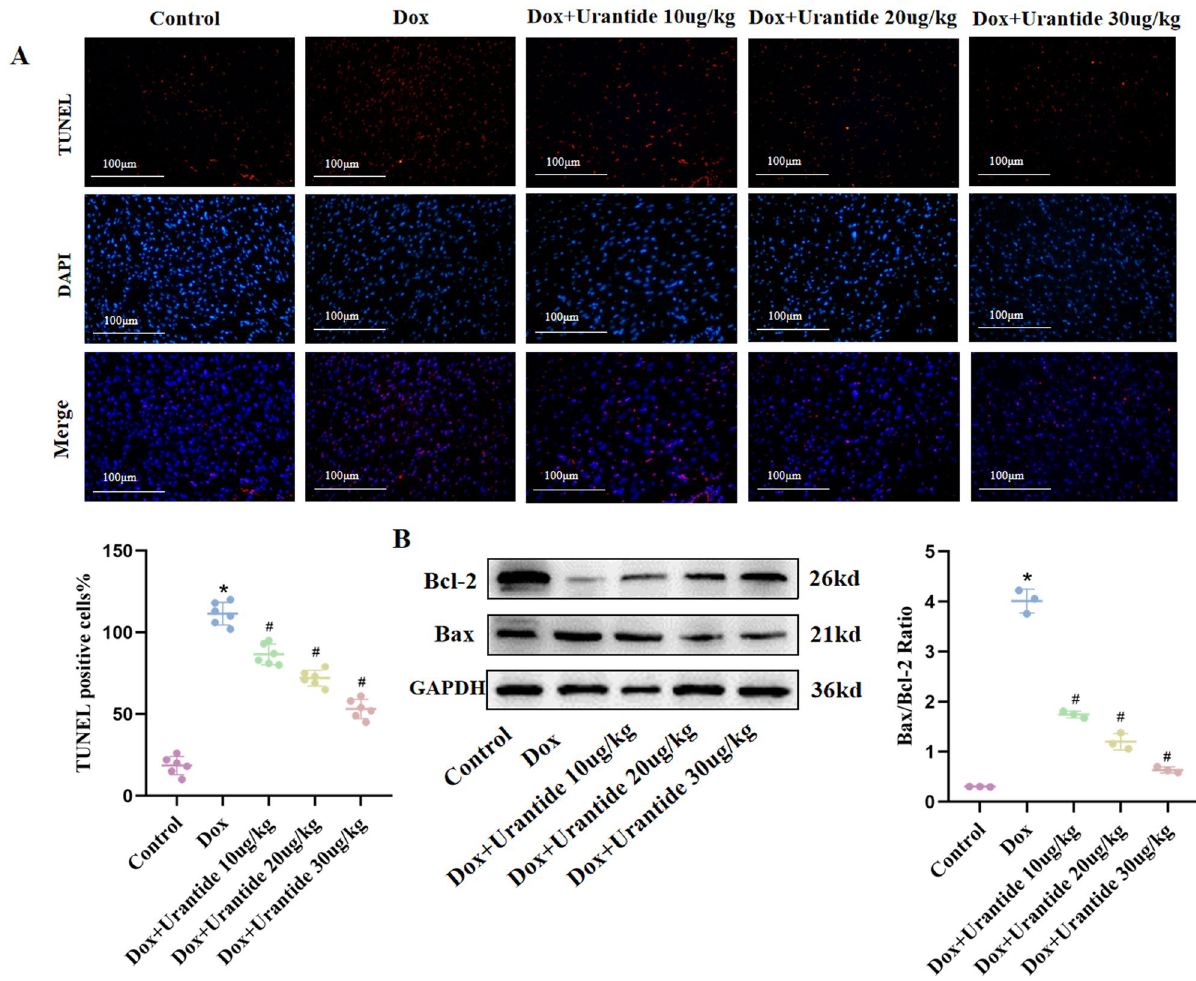
Figure 4. Urantide attenuates DOX-induced apoptosis in vivo. ( A ) Staining cells with red indicated TUNEL ‐ positive cells, DAPI staining (blue) indicated nucleus. Bar = 100 μm. Percentages of TUNEL ‐ positive cells of total cells were shown. ( B ) Protein expression of Bcl ‐ 2 and Bax in the different treatment groups. (n = 6). *P < 0.05, vs. the control; # P < 0.05 vs. the DOX